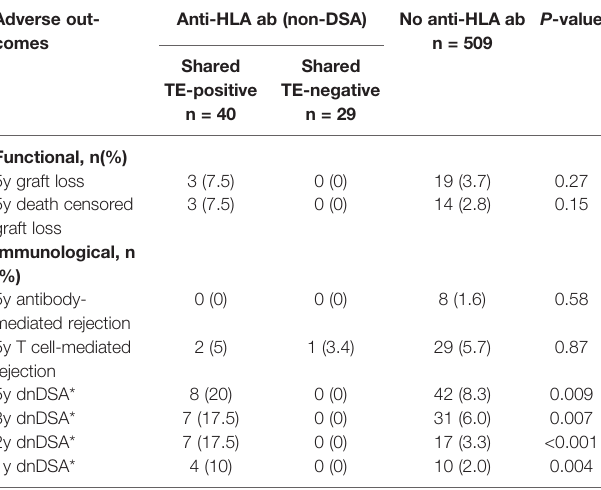
TABLE 5 | Cumulative incidences of graft loss, rejection, and dnDSA.